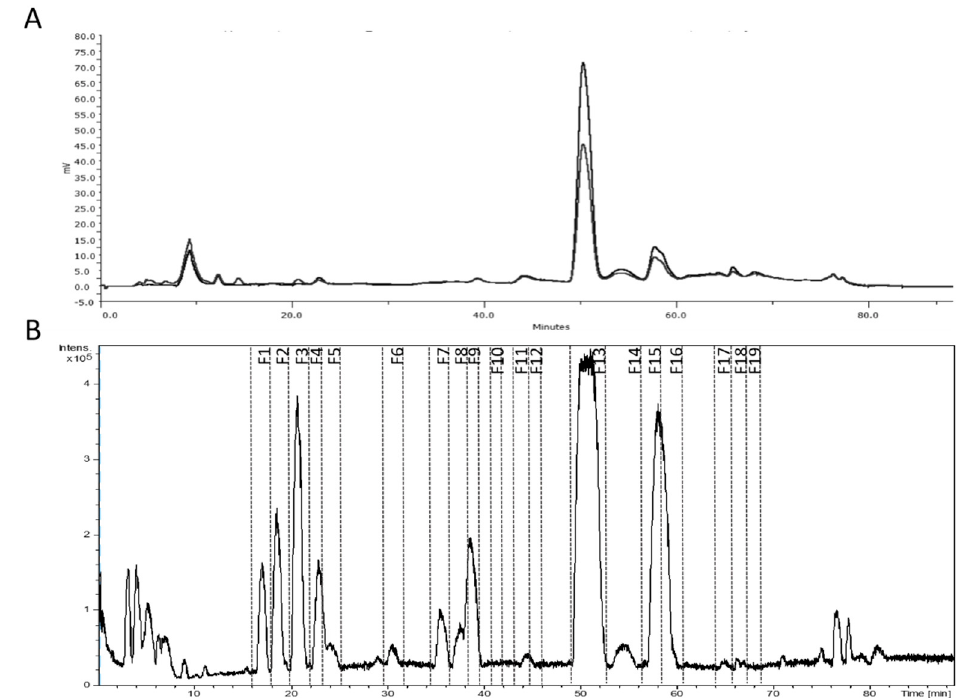
Figure 3. ( A ) UV chromatogram (240 and 280 nm) obtained by the semi-preparative HPLC system and ( B ) base peak chromatogram monitored by the ESI-TOF mass spectrometer, indicating the collected fractions from the commercial lemon verbena extract (PLX ® 10). Table 2. Collected fractions from a commercial lemon verbena extract (PLX ® 10) by semi- preparative chromatography, indicating the major compound(s) identified by HPLC-ESI-TOF- MS, the dry weight of the residue of each fraction and the relative amount taking account the injected quantity. Bold numbers correspond to the peaks with the highest intensity in each isolated fraction.